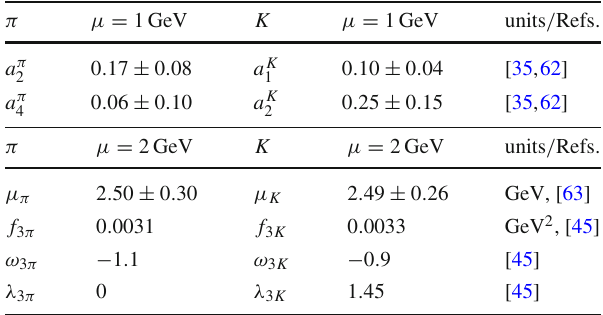
Table 1 The nonperturbative input parameters of the pion and kaon distribution amplitudes in our calculations π μ = 1GeV K μ = 1GeV units / Refs .